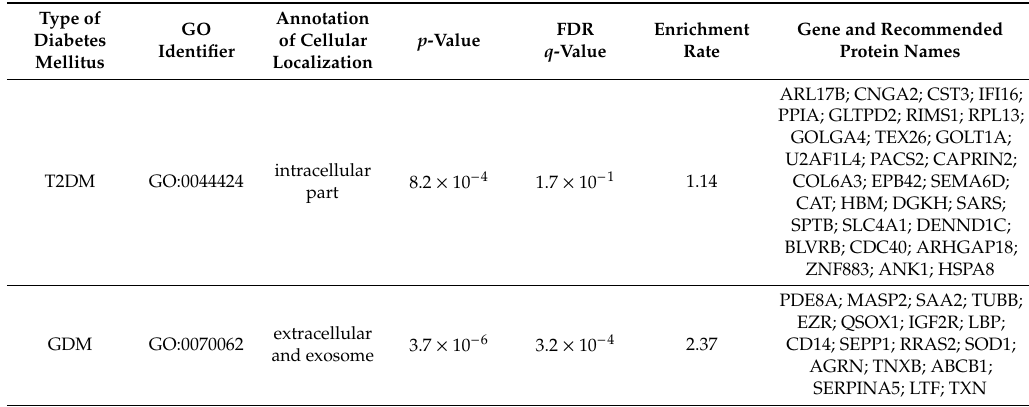
Figure 1. The hierarchical clustering of biologic processes for proteins determined specifically for groups with GDM and type 2 diabetes mellitus (T2DM). Patients with GDM are mostly characterized by proteins involved in positive regulation of macromolecule metabolic processes (GO:0010604, p = 8.38 × 10 − 4 ), whereas patients with T2DM are featured by transport proteins (GO:0006810, p = 8.24 × 10 − 4 ). This partially assigned to unequivocal mechanisms of chronic insulin resistance and glucose metabolism impairment between happened T2D and occurred GDM in the course of gestation. Table 2. The identified proteins were clustered according to their cellular localization in terms of GO. Patients from the T2DM groups were assigned to intracellular localization while most proteins specified for GDM groups were characterized by extracellular and exosome